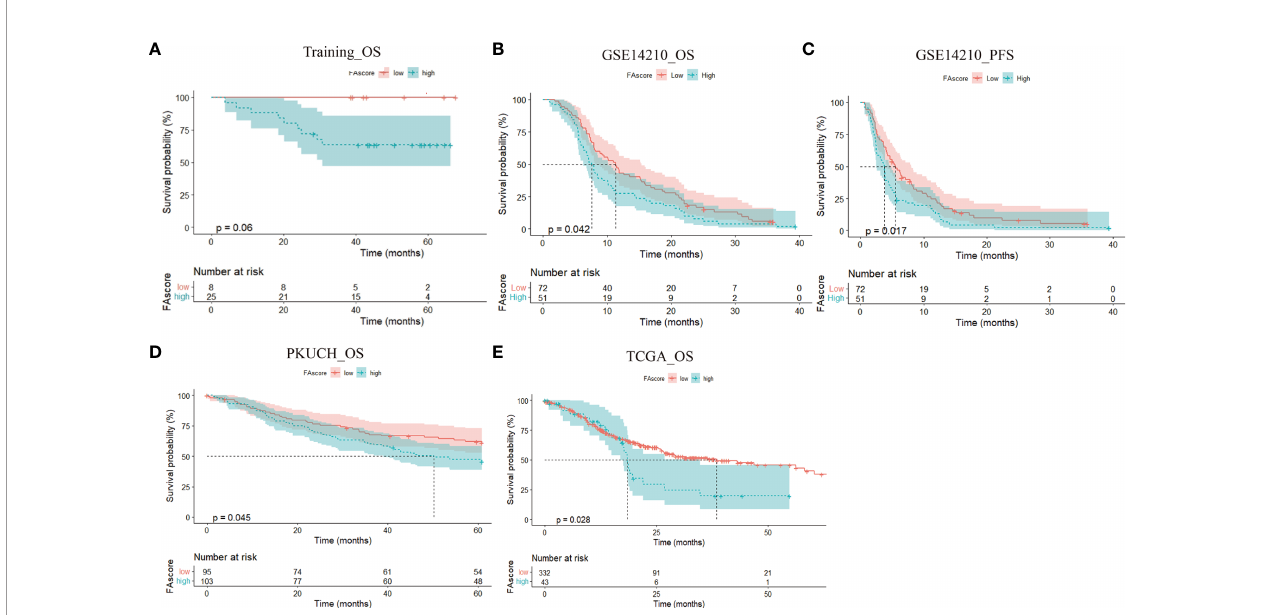
FIGURE 4 | The prognostic value of the established focal adhesion-related model. High FAscore discriminated poor prognosis patients in different cohorts, including the training cohort (A) ,GSE14210 cohort (B, C) , Peking University Cancer Hospital (PKUCH) cohort (D) , and the Cancer Genome Atlas (TCGA) cohort (E)